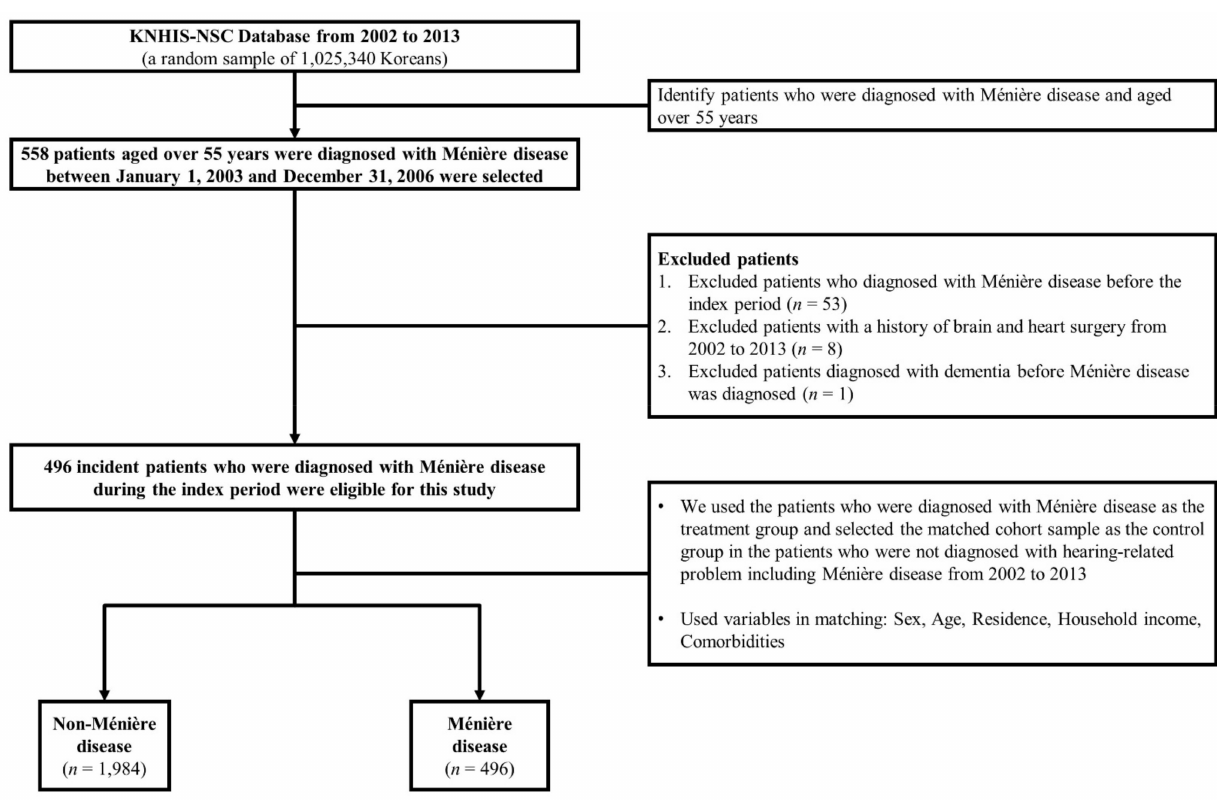
Figure 1. Schematic description of the study design.